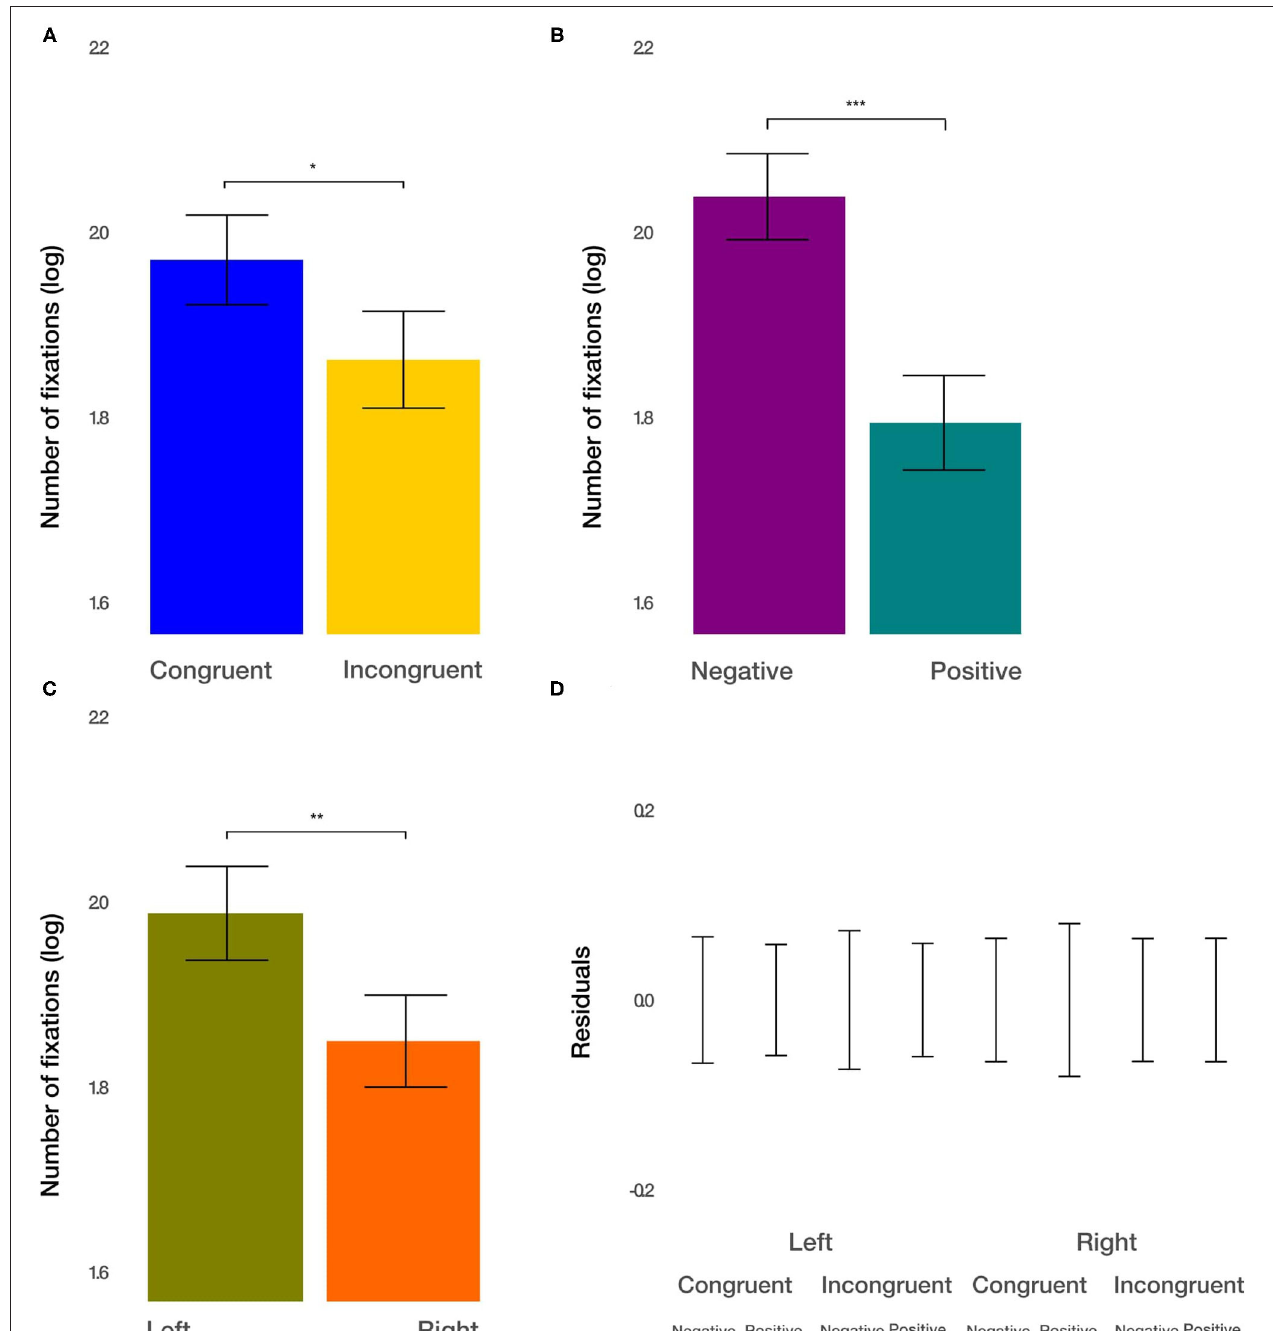
FIGURE 5 | The number of fixations results. (A) The main effect of the congruency of the priming. (B) The main effect of valence (negative vs. positive). (C) The main effect of the side (left vs. right). (D) Averaged residuals of all condition combinations from the number of fixations linear mixed model. In all plots, bars represent mean values and whiskers standard error of the mean. Stars represent significance levels: * p < 0.05, ** p < 0.01, and *** p < 0.001.